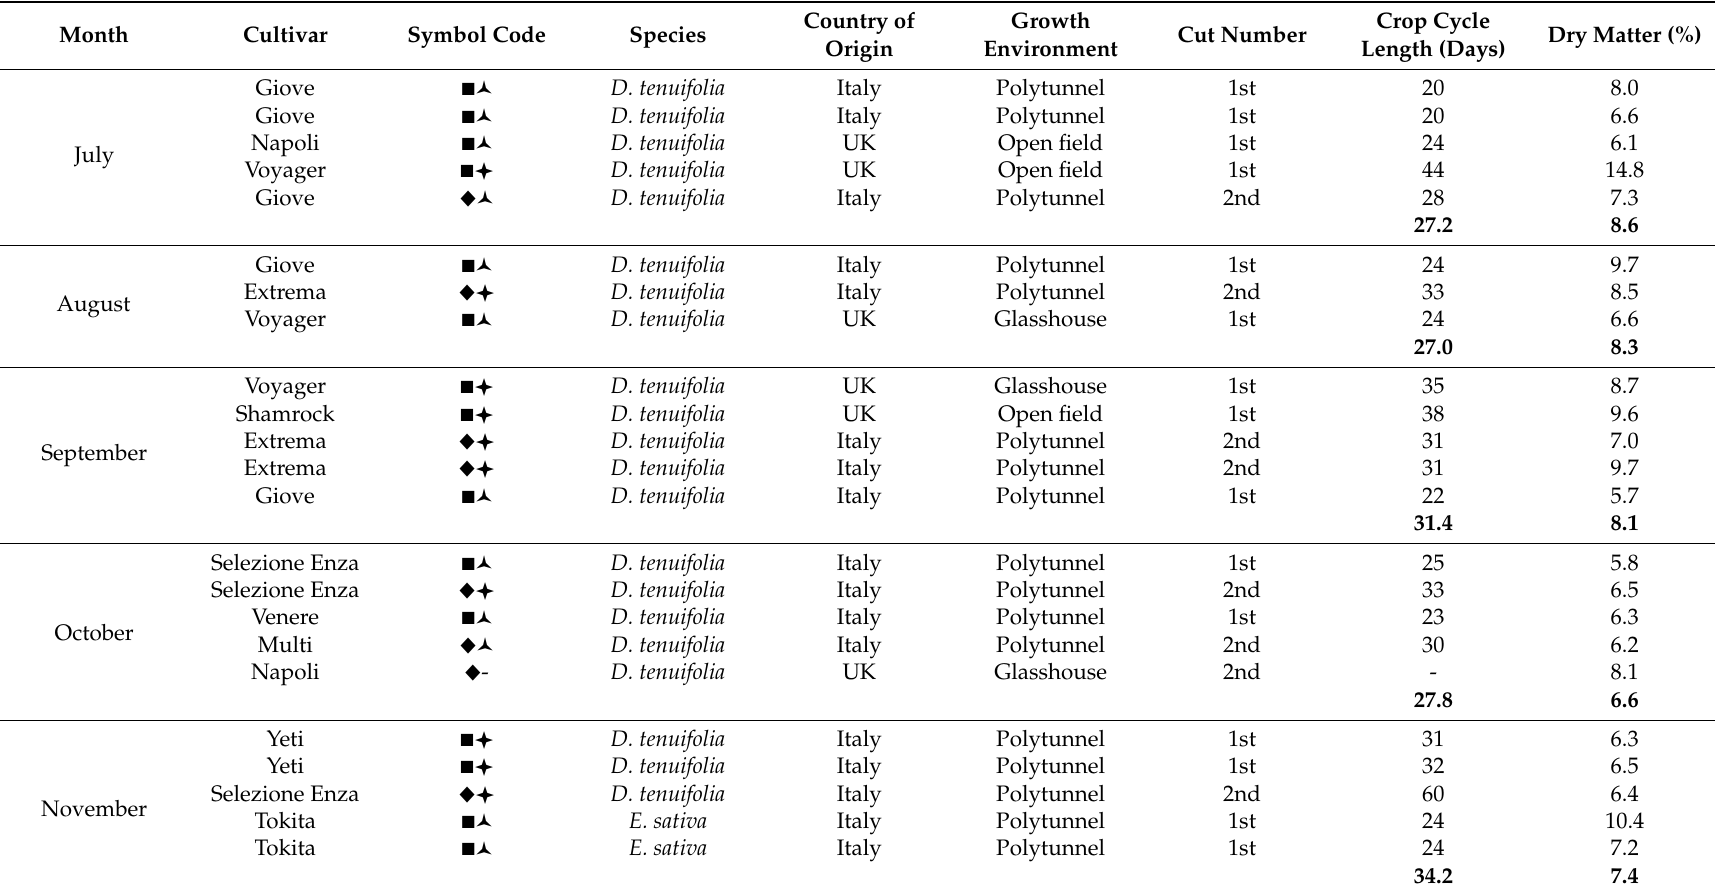
Table 1. Cultivation and origin details of rocket samples used for sensory and consumer analyses.